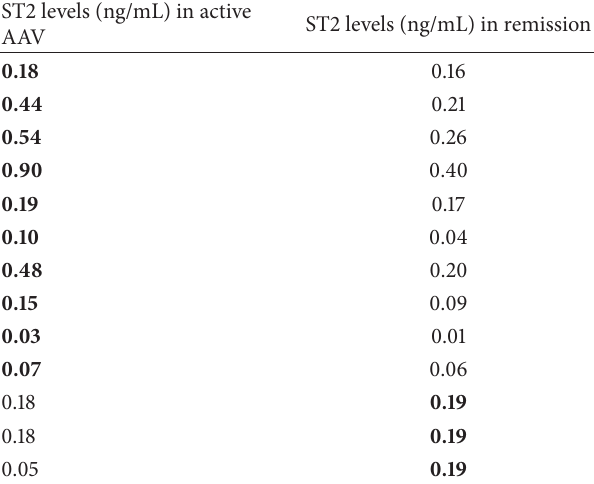
Table 4: ST2 levels in patients, who were sampled repeatedly in different phases of disease (active newly diagnosed AAV → remission, or remission → relapse) ( higher levels displayed in bold